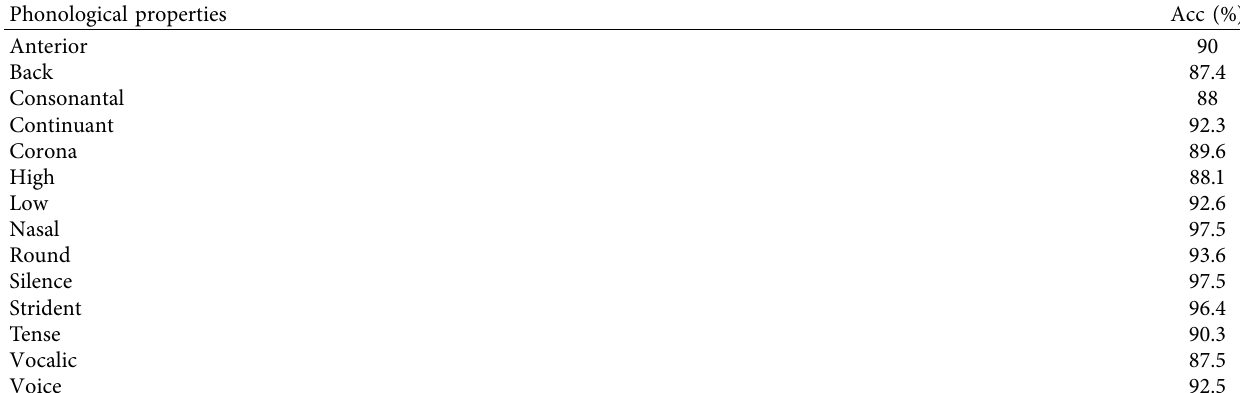
Table 3: Test results of SPE attributes in test set.